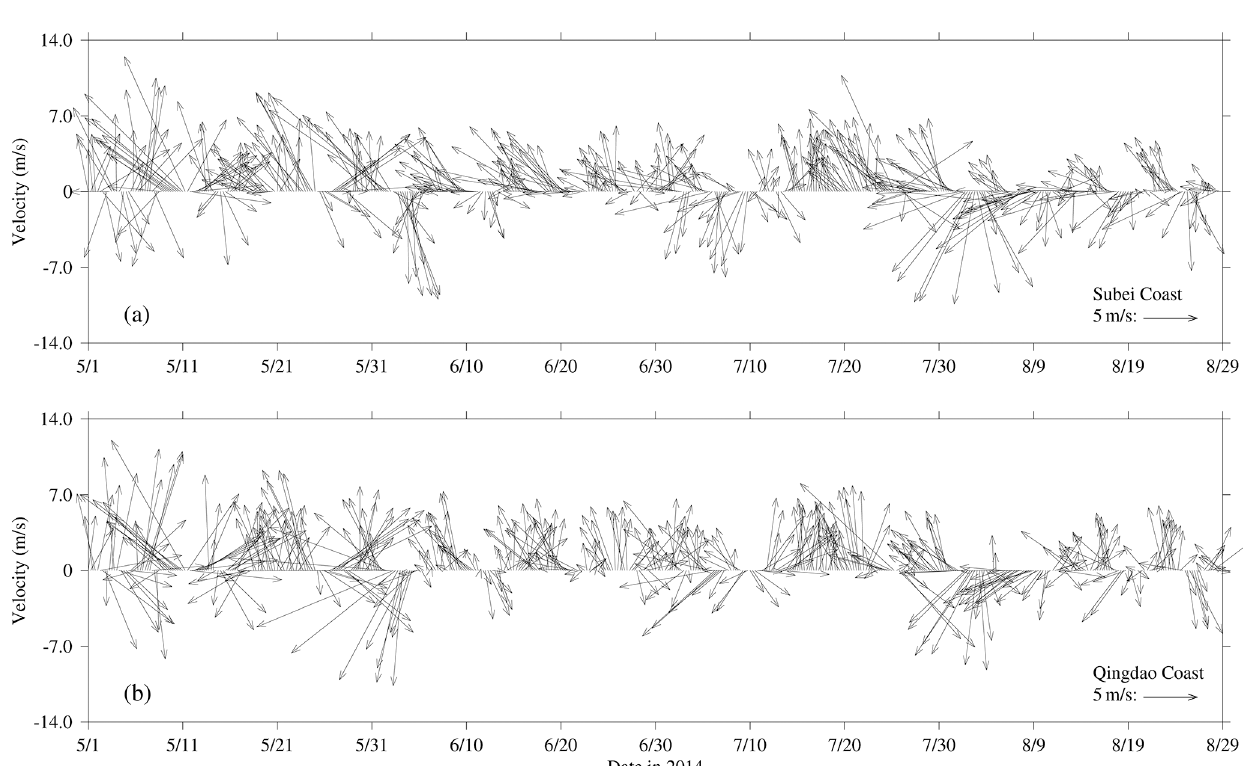
Figure 4. Wind vectors at 10m height near the Subei coast (a) and Qingdao coast (b) at a time interval of 6h from May to August 2014.